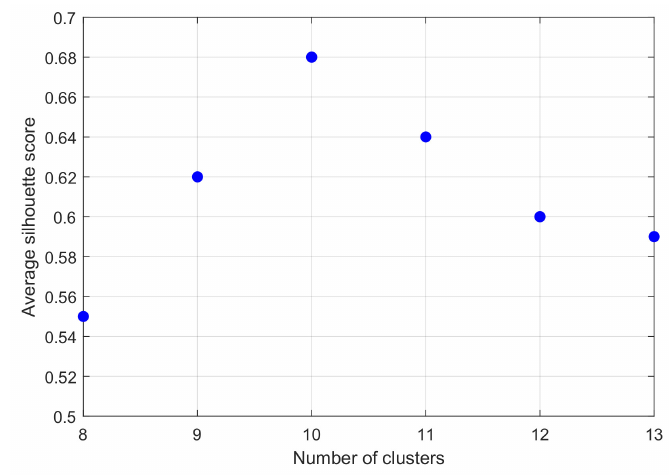
Figure 6. Using the silhouette method to define number of clusters.